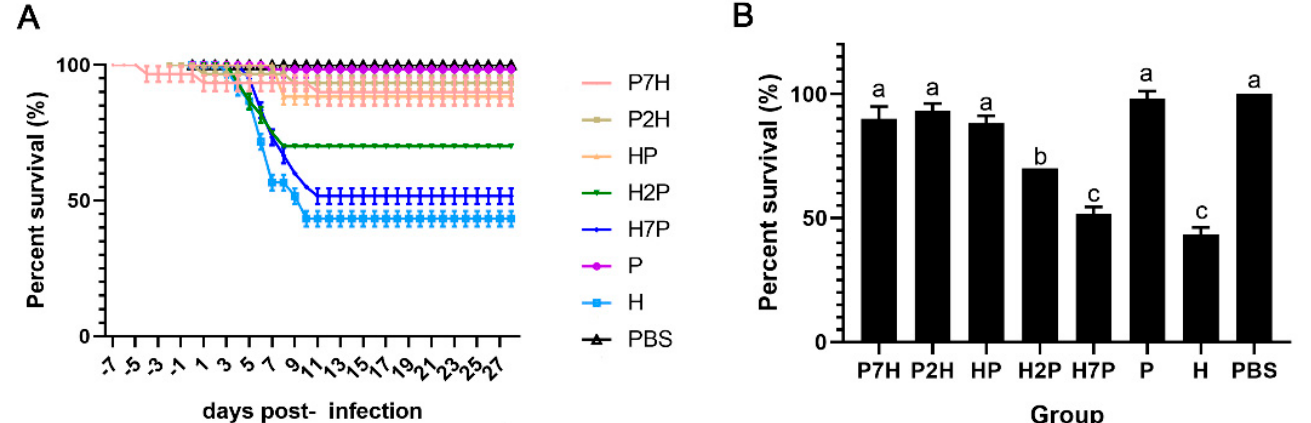
Figure 2. Kaplan–Meier survival curves and survival rate of rainbow trout challenged with IPNV and/or IHNV. Rainbow trout mock challenged with PBS were used as blank control. Deaths caused by IPNV and/or IHNV were recorded daily for 28 days. Different letters indicate statistically significant differences ( p < 0.05). ( A ) Kaplan–Meier survival curves. ( B ) Significant difference analysis of survival rate.